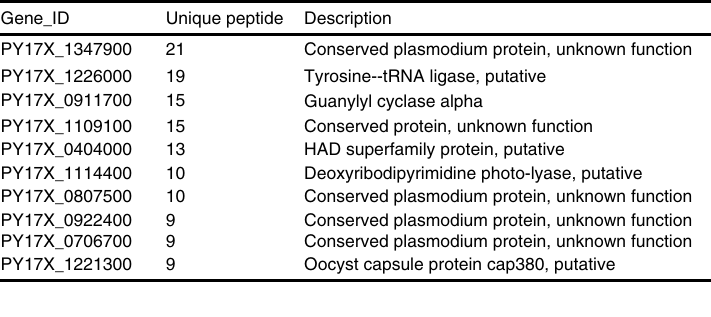
Top 10 GEP1 interacting proteins detected via IP-Mass spectrum